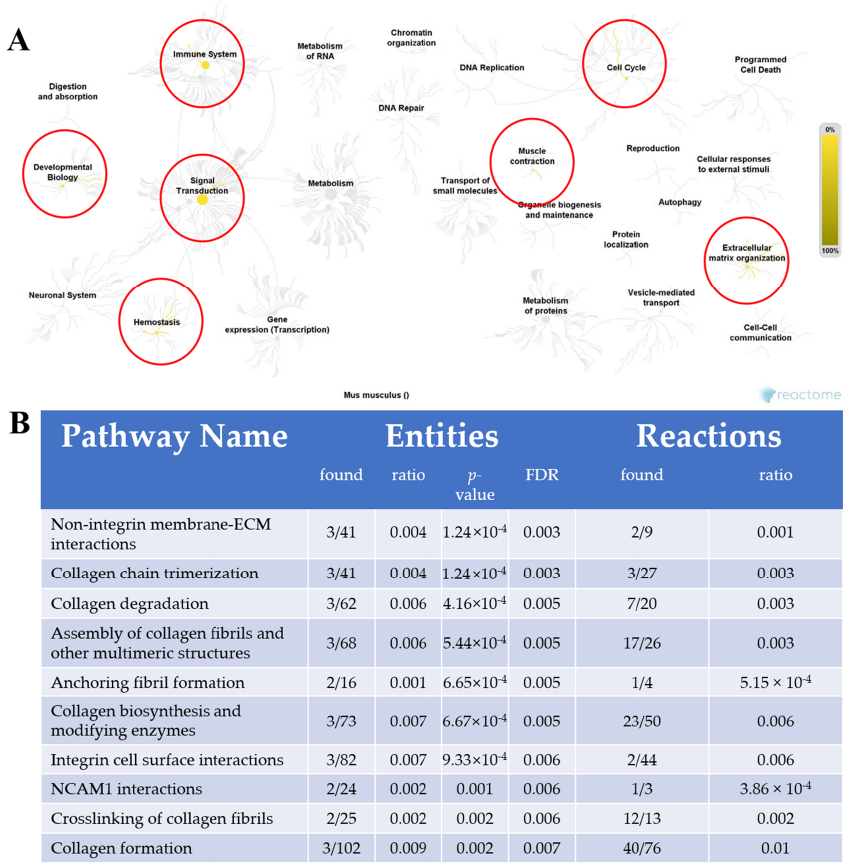
Figure 5 Figure 5. Proposed pathways for cardiac impairment caused by PGR. ( A ) Pathway network generated by REACTOME (yellow lines: 42 pathways involved). The most notable pathway hubs (red circles) were extracellular matrix organization (ECM), cell cycle, muscle contraction, signal transduction, developmental biology, immune system, and hemostasis. ( B ) Representative image generated by REACTOME of the 10 most relevant pathways sorted by p -value ( < 0.05), shown in a table. FDR: false discovery